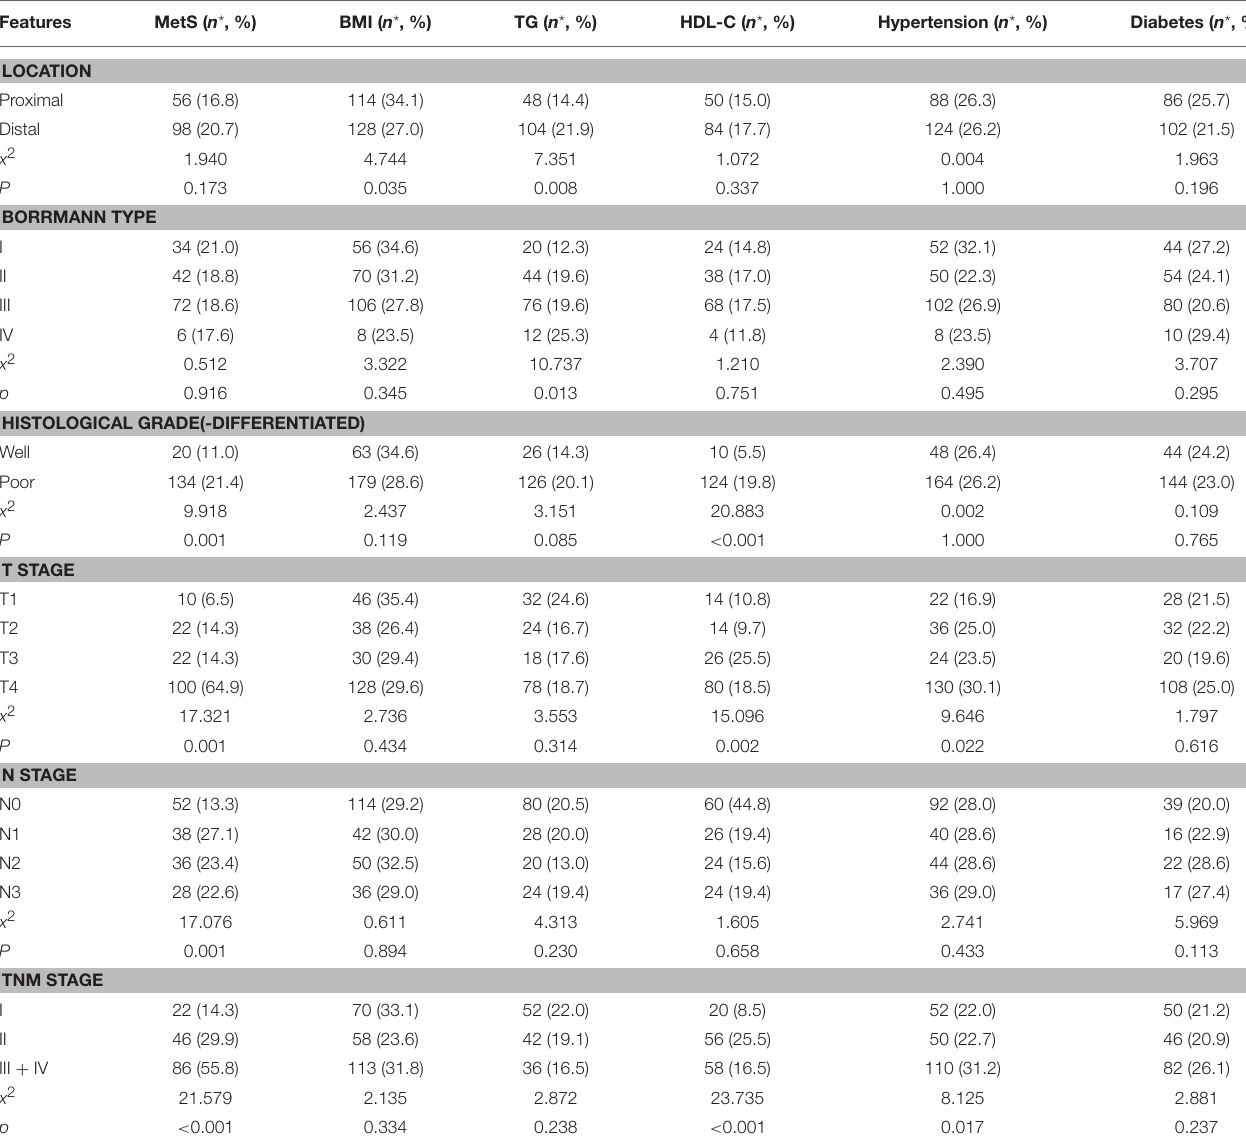
TABLE 4 | Comparison of clinicopathological characteristics between gastric cancer patients with and without metabolic syndrome by CDS definition.